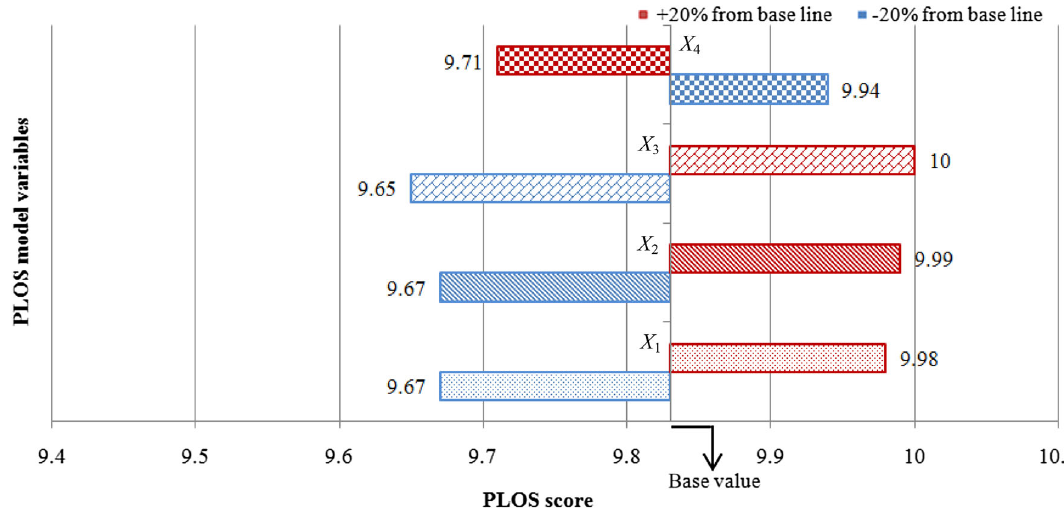
Fig. 5 Tornado diagram for sensitivity analysis of PLOS model